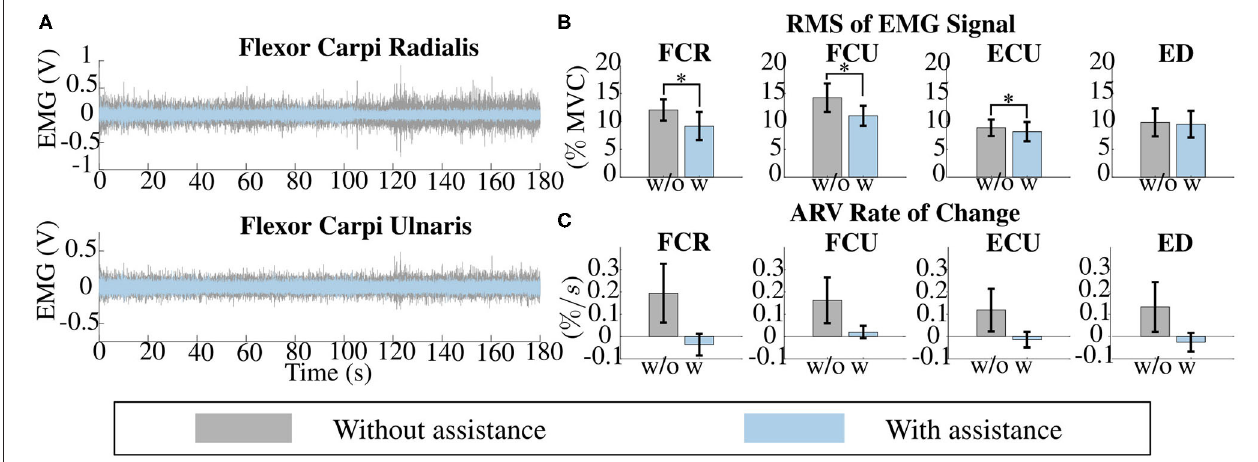
FIGURE 8 | Fatigue analysis. (A) The raw signal of the electromyography (EMG) of the flexor carpi radialis (FCR) and of the flexor carpi ulnaris (FCU) of one subject, during the isometric task, for both the unpowered (gray) and powered condition (light-blue). (B) The overall mean of the 4 muscle’ EMG signals, averaged over subjects, indicate that the assistance from the exosuit reduces the subject’s muscular activity when a static holding of a load is performed. FCR, FCU, and extensor carpi ulnaris (ECU) EMG reduction were statistically significant ( p < 0.01). (C) The slope of the ARV of the EMG signals, averaged over subjects and expressed in percentage of its initial value. A steeper positive slope for the ARV indicate a faster onset of fatigue (Merletti and Parker, 2004). These indices confirm that wearing the exosuit reduces the onset of fatigue. Error bars show the standard error of the mean. *means data are statistically significant with p <